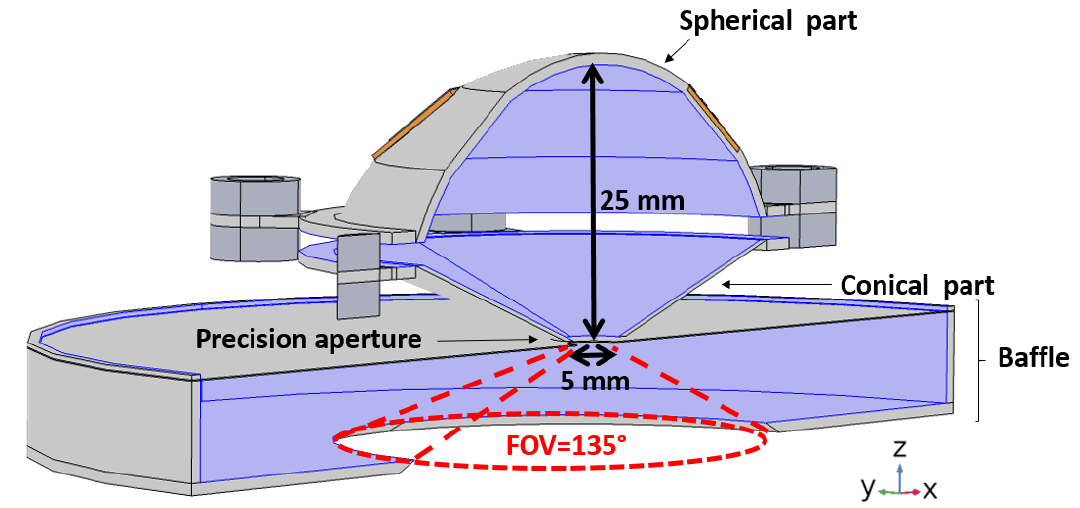
Figure 2. 3D view of a section of the radiometer. The cavity is composed of a spherical part and a conical part. The precision aperture and baffle limit the field-of-view (FOV) to 135 ◦